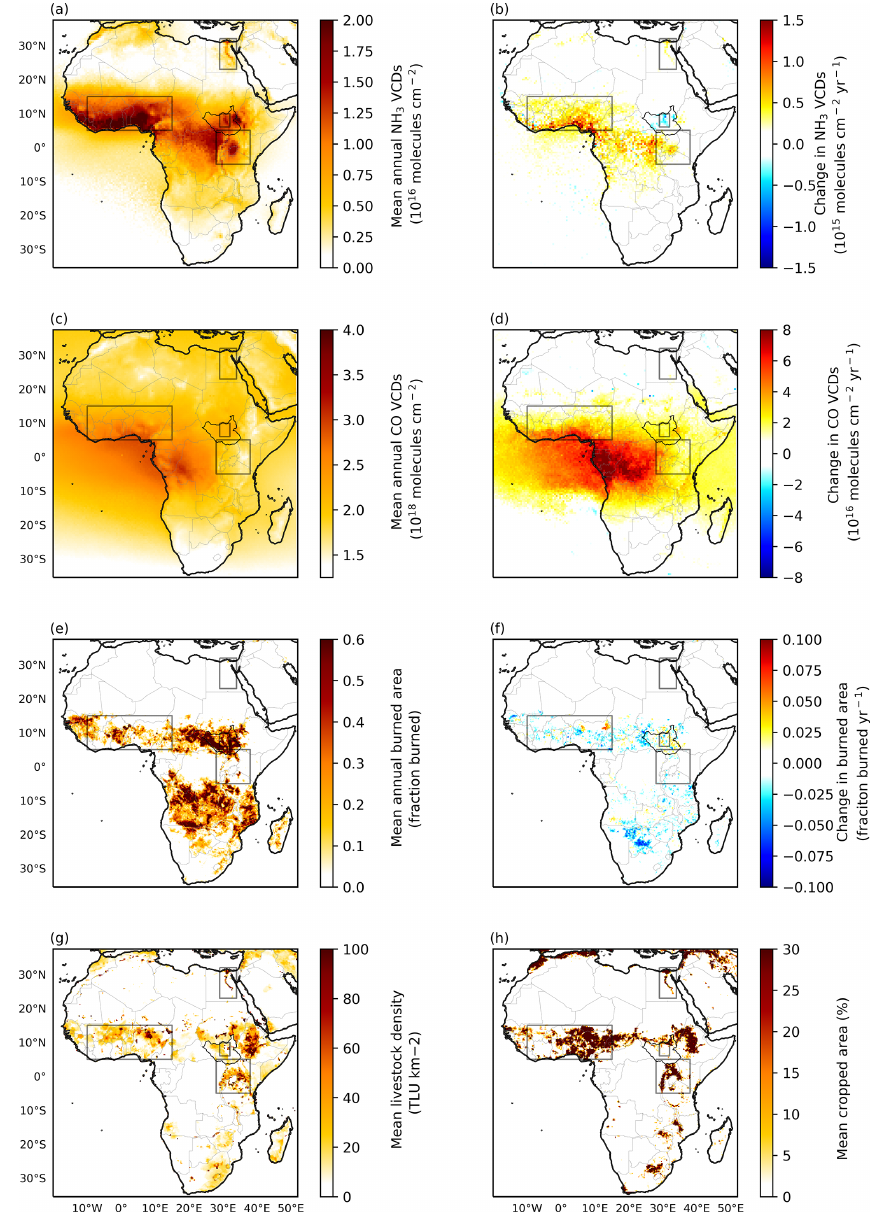
Figure 1. Annual averages and trends in atmospheric NH 3 VCDs, CO VCDs, and burned area as well as spatial distribution of livestock density and cropped area across seven sub-Saharan African ecoregions. Mean annual (a) and trend (b) in atmospheric NH 3 VCDs from IASI for the period 2008 through 2018. Mean annual (c) and trend (d) in annual atmospheric CO VCDs from IASI for the same period. Mean annual (e) and trend (f) in annual burned area from MODIS for 2008–2018. Livestock densities for 2007 from the FAO (g) , and mean cropped area from MODIS for 2008–2018 (h) . The border of South Sudan is highlighted in black, and several regions are boxed: the Nile region at 30 ◦ N, the Sudd wetland in South Sudan, the Lake Victoria region at the Equator, and West Africa centered around 10 ◦